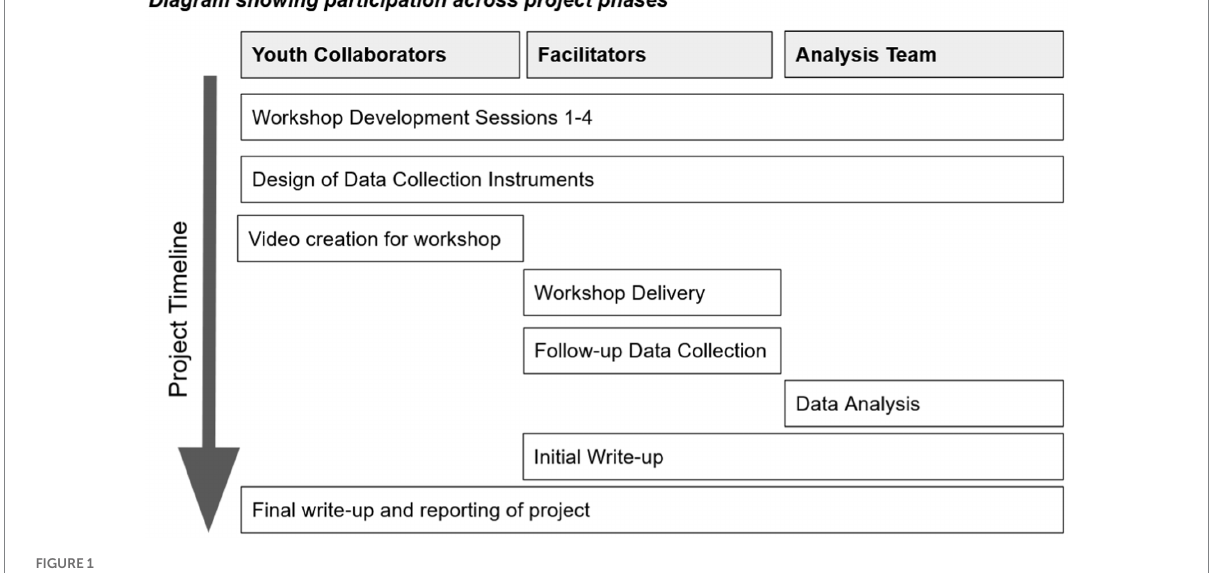
FIGURE 1 Co-creation